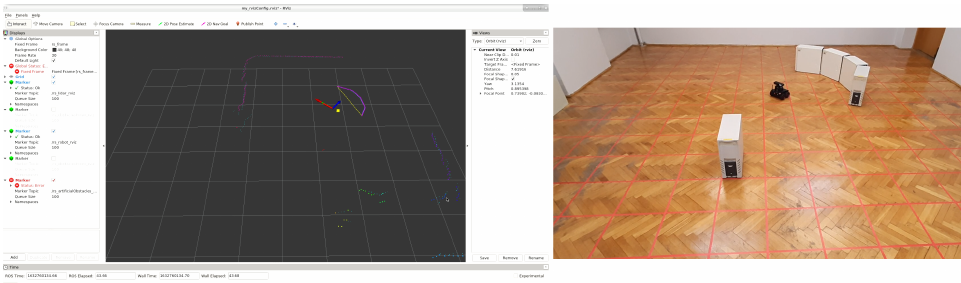
Figure 14. Real photo and RViz visualization at the same timestamp as the image number V in Figure 13.